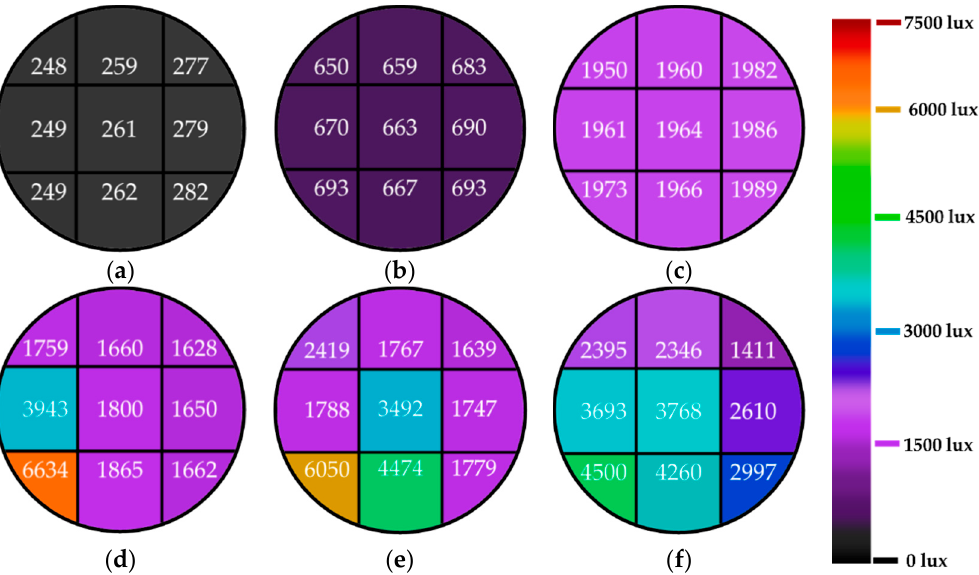
Figure 4. Internal illumination contours of the aluminum alloy tube on the top end for the incident light angles of ( a ) 0°,